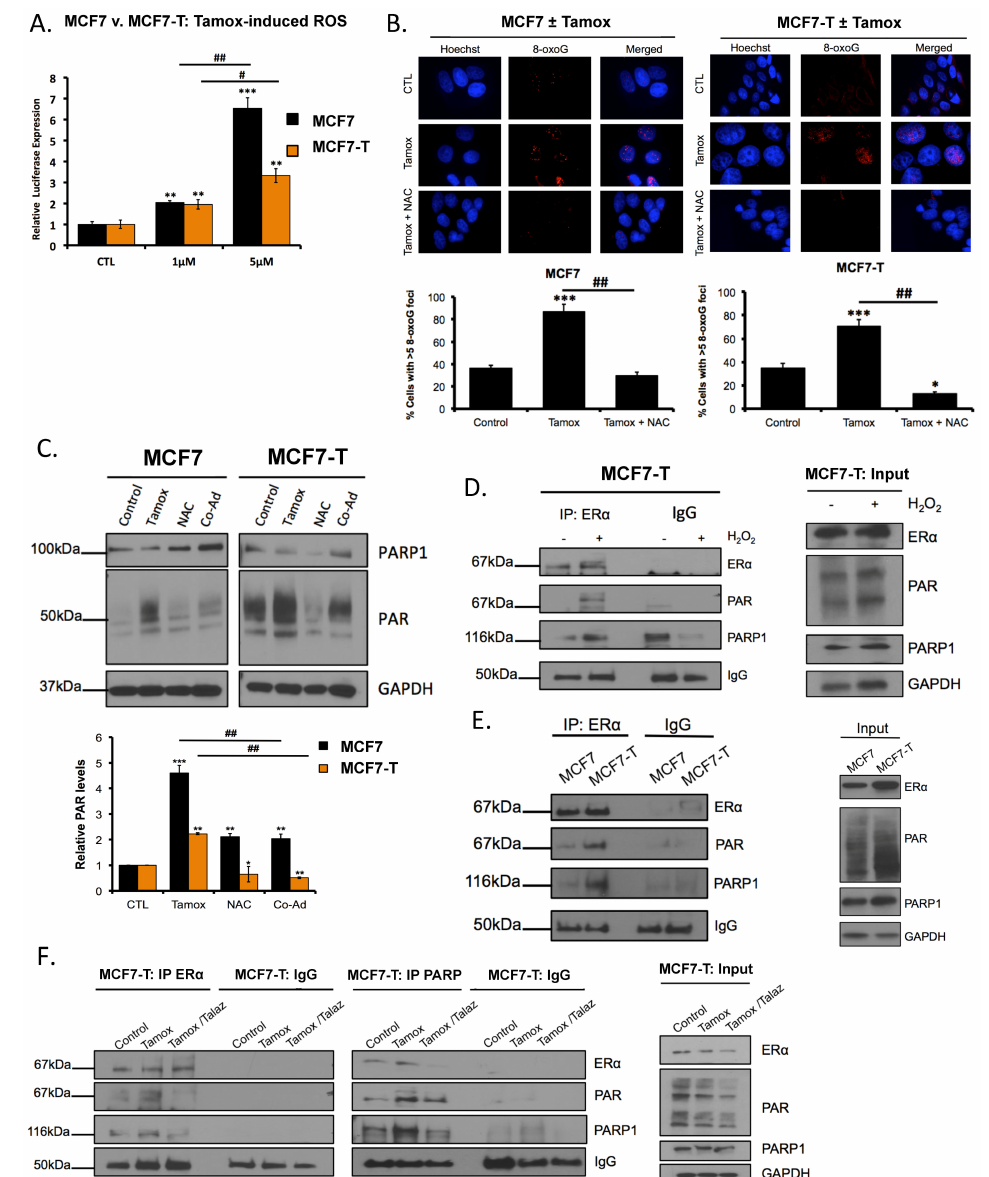
Figure 3. Tamoxifen-induced ROS accumulation promotes ER α PARylation. ( A ) MCF7 and MCF7-T cells were treated with the increasing concentrations of tamoxifen (Tamox) for 4 h, and subjected to ROS assay. ( B ) MCF7 and MCF7-T cells were treated with Tamox (1 µ M) in the presence and absence of 1 mM N -acetyl- L -cysteine (NAC). 24 h post treatment immunofluorescence staining of 8-hydroxyguanosine (8-oxoG) was performed. Results are representative of three independent experiments, and quantified below. Scale bar: 20 µ m. ( C ) MCF7 and MCF7-T cells were treated with 100 nM Tamox with or without 1 mM NAC (ROS scavenger). 24 h post treatment cell lysates were subjected to western blot analysis. ( D ) MCF7-T cells were treated with 2 mM H 2 O 2 for 4 h. Treated cells were subjected to immunoprecipitation (ER α ) and western blot analysis against the indicated antibodies. ( E ) MCF7 and MCF7-T subjected to immunoprecipitation (ER α ) and western blot analysis against the indicated antibodies. ( F ) MCF7-T cells were treated for 4 h with 100 nM Tamox with or without 1 nM talazoparib (Talaz; pre-treat 24 h). Post treatment cells subjected to immunoprecipitation and western blot analysis against the indicated antibodies. * p < 0.01, ** p < 0.001, *** p < 0.0001 compared to control, # p < 0.01, ## p < 0.001 relative to bracketed